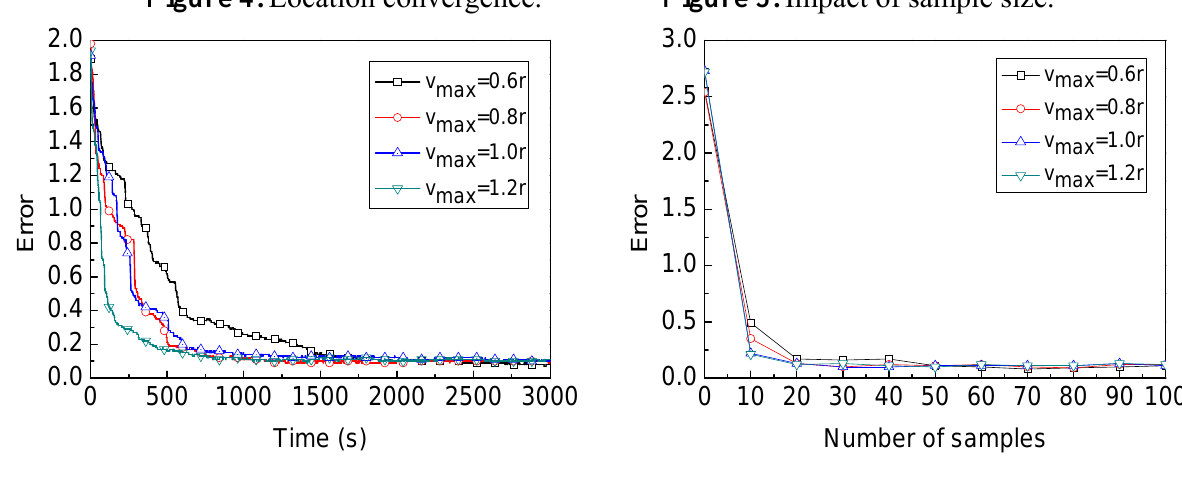
Figure 5. Impact of sample